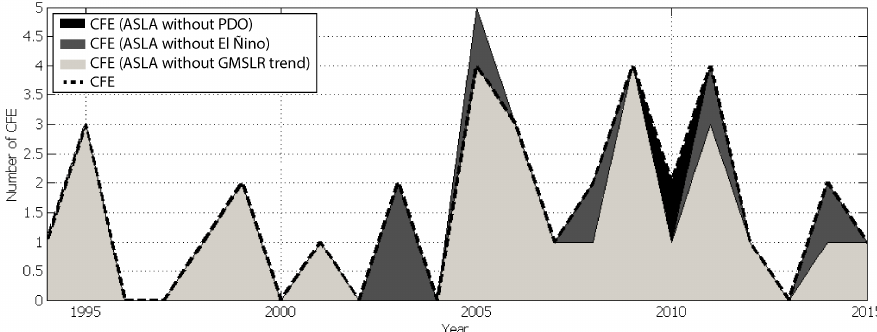
Figure 4. Annual number of CFEs for the period 1993‐2015, computed using the raw altimetry NTR time series (black dashed line); other curves indicate the effects of removing the GMSLR trend from the NTR signal (light gray area); removing El Ñino (dark gray area) and PDO (black area) components from the NTR signal.